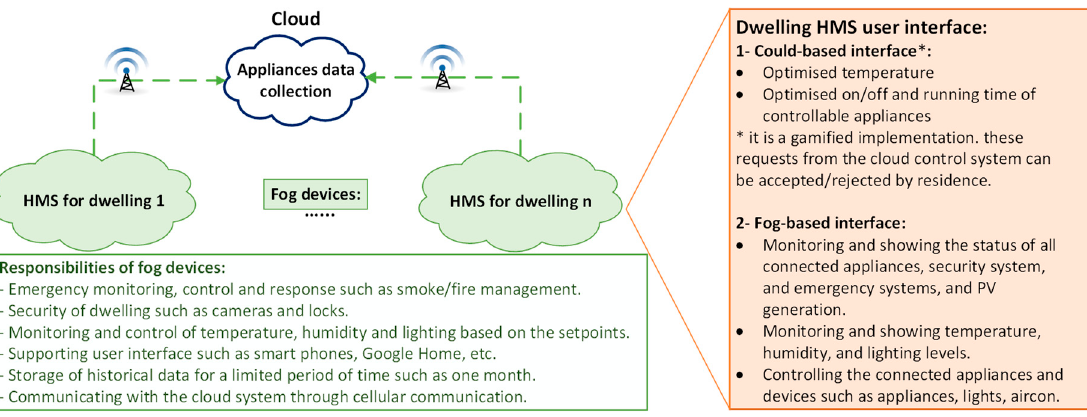
Figure 7. The proposed fog ‐ based configuration and user interface for dwellings.